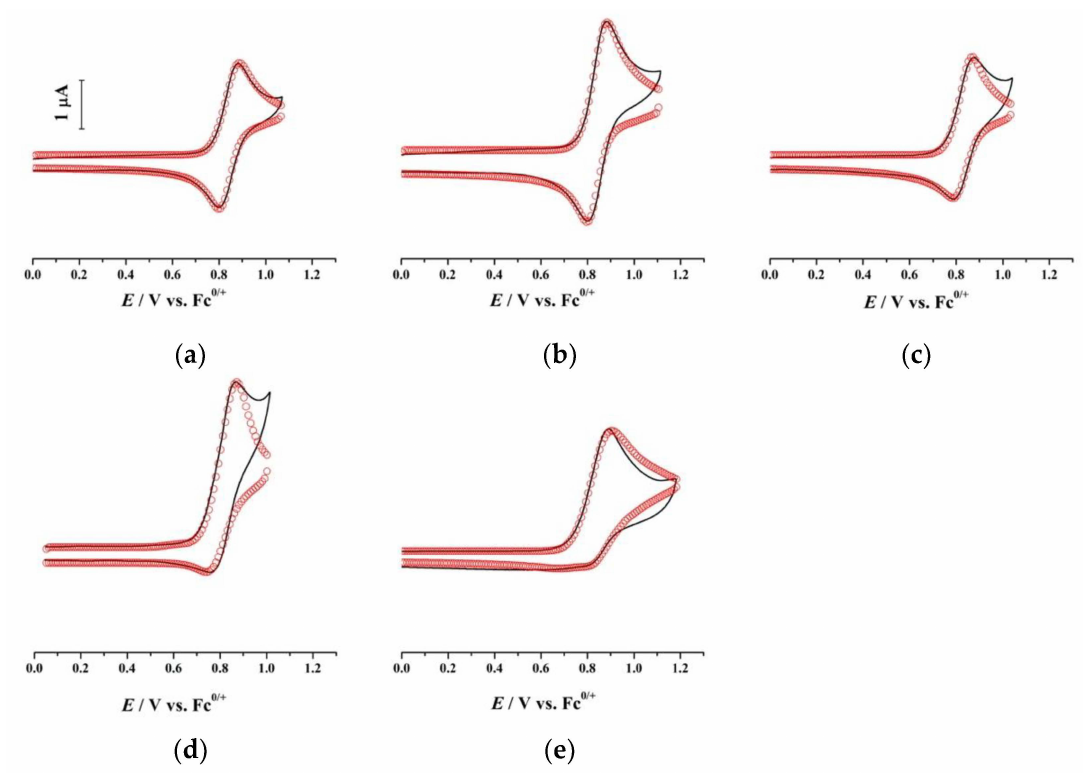
Figure 4. Comparison of experimental (solid lines) and simulated (open circles) cyclic voltam- mograms for the oxidation of 5 mM 1 in ( a ) [bmpyr][NTf 2 ], ( b ) [emim][NTf 2 ], ( c ) [bmim][BF 4 ], ( d ) [emim][OTf], and ( e ) [bmim][PF 6 ]. The mechanism depicted in Scheme 1 and data from Table 1 were used for simulations. Scan rate = 0.20 Vs − 1 . T = 294 K, electrode area = 0.7 mm 2 , charge- transfer coefficient = 0.5, heterogeneous standard rate constant = 1.0 × 10 − 2 cm s − 1 , double-layer capacitance = 0.60 µ